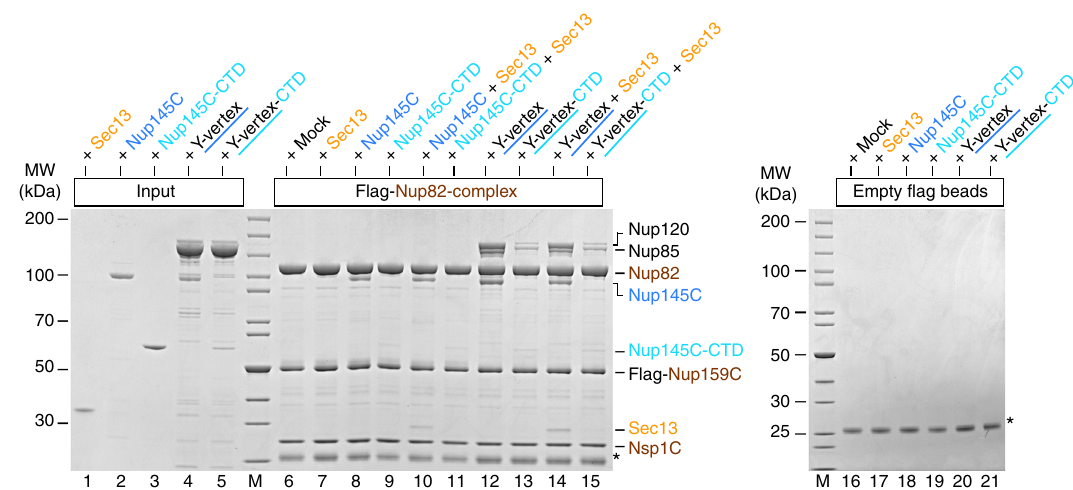
Fig. 3 Interaction between the Ct Nup82 complex and the Ct Y-vertex. In vitro binding assay with the immobilized Ct Nup82 complex (Flag- Ct Nup159C – Nup82 – Nsp1C) and different soluble prey proteins of the Ct Y-shaped complex. Shown is the analysis of SDS eluates by SDS-PAGE and coomassie staining. The experiment was performed at least twice with consistent results. The asterisk indicates bands corresponding to the anti-Flag light chain; M marker, Mock puri fi cation buffer with E. coli whole cell lysate, MW molecular weight, Y-vertex co-puri fi ed Ct Nup145C – Nup85 – Nup120 complex, Y-vertex-CTD co-puri fi ed Ct Nup145C-CTD – Nup85 – Nup120 complex. Uncropped images of the gels are shown in Supplementary Fig. 4c,